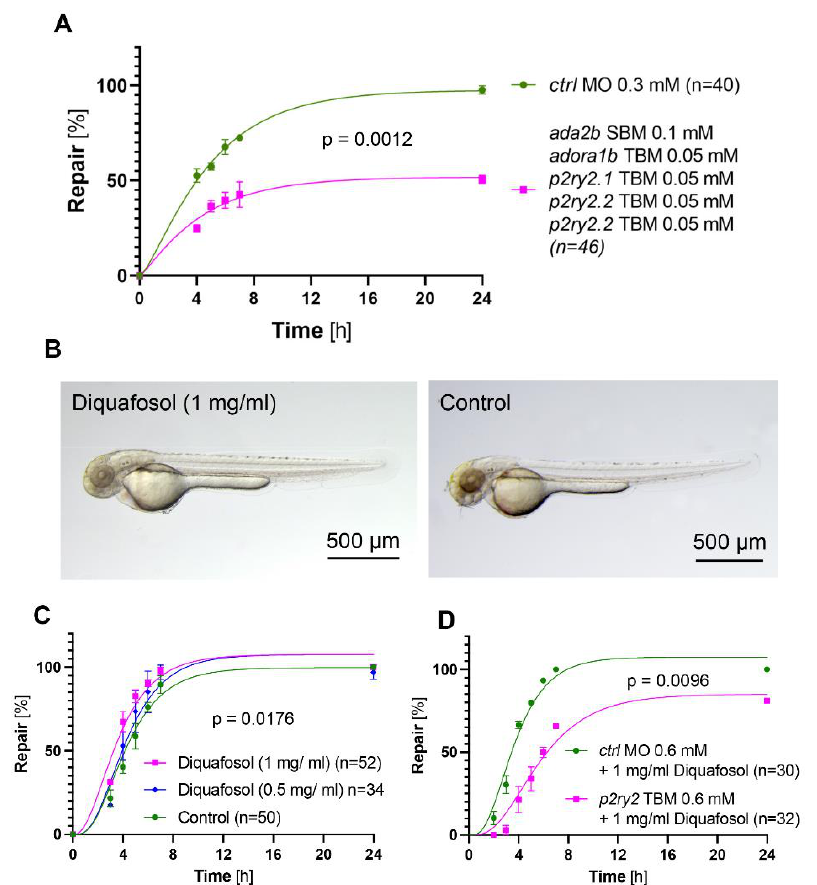
Figure 5. Effect of the combined adenosine pathway knockdown, and of the P2YR2 agonist Di- quafosol on the repair process. ( A ) Combined depletion of ada2b , adora1b , p2ry2.1 , p2ry2.2 and p2ry2.3 with low concentrations of MOs significantly delayed the repair process (mean ± SEM; 2-way Anova). ( B ) Diquafosol (1 mg/mL) did not affect zebrafish development. ( C ) Diquafosol exposure for 3 h before, and for 24 h after laser-induced injury resulted in accelerated repair (mean ± SEM; 2-way Anova). ( D ) Depletion of zebrafish p2ry2 variants by translation-blocking morpholino oligonucleotides (MO) prevented the accelerating effect of Diquafosol.